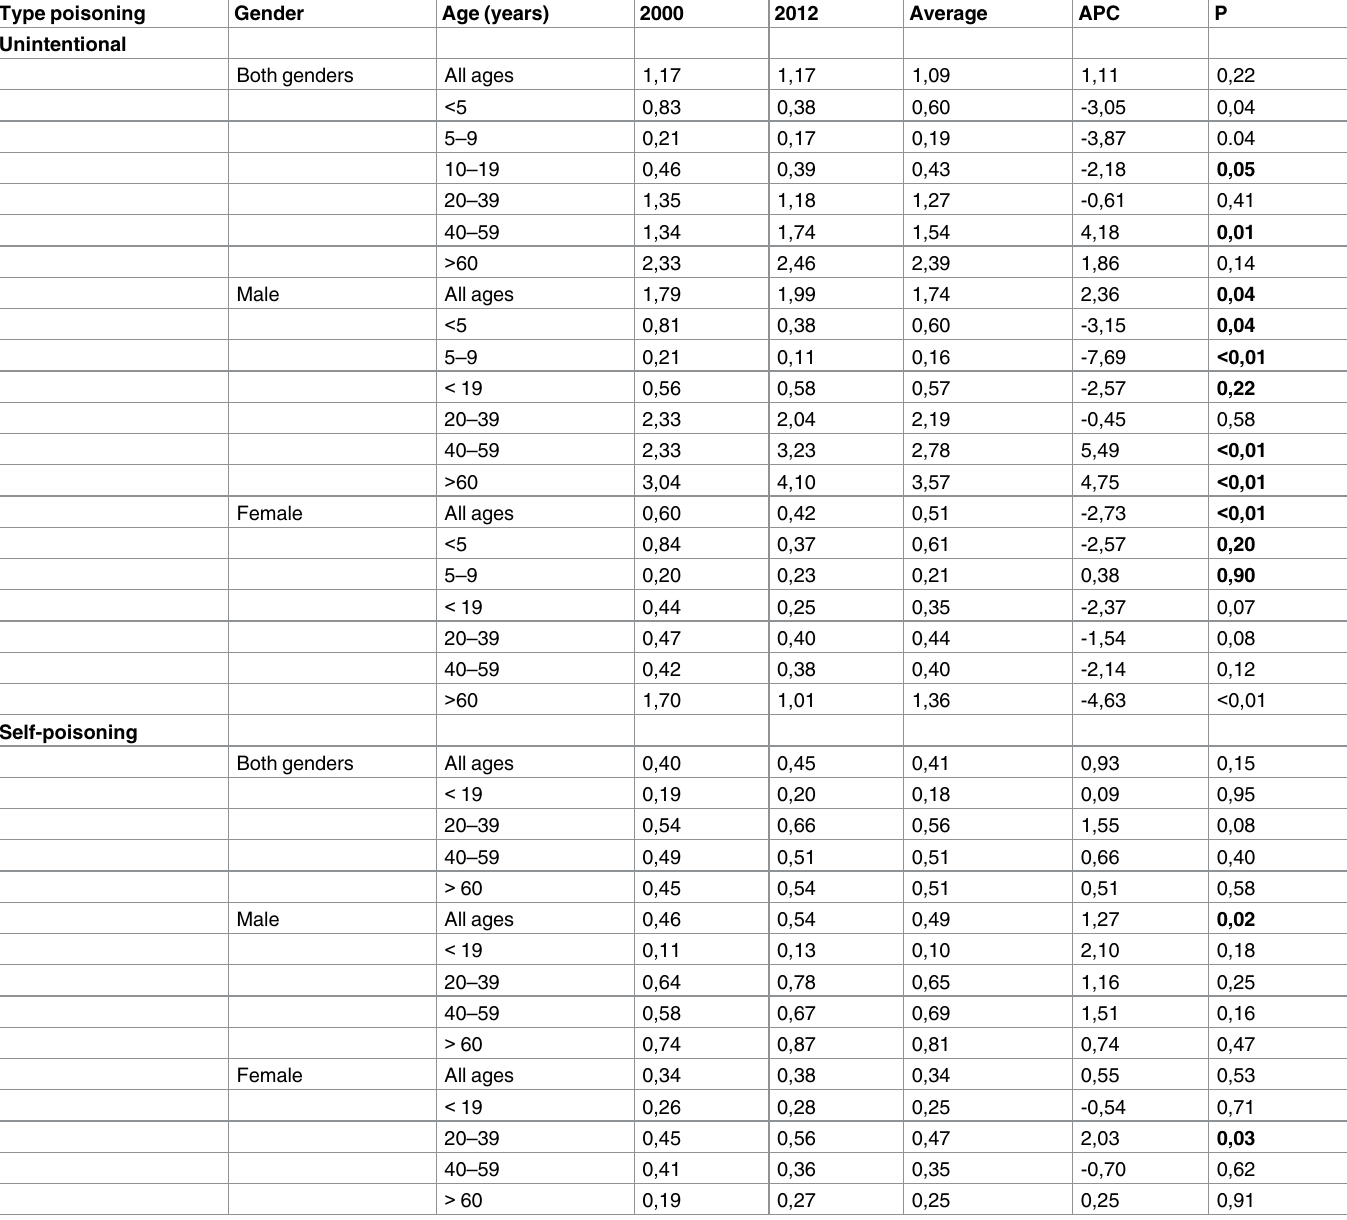
Table 2. Trends in unintentional and self-poisoning mortality in Mexico (rates are by 100000population). Type